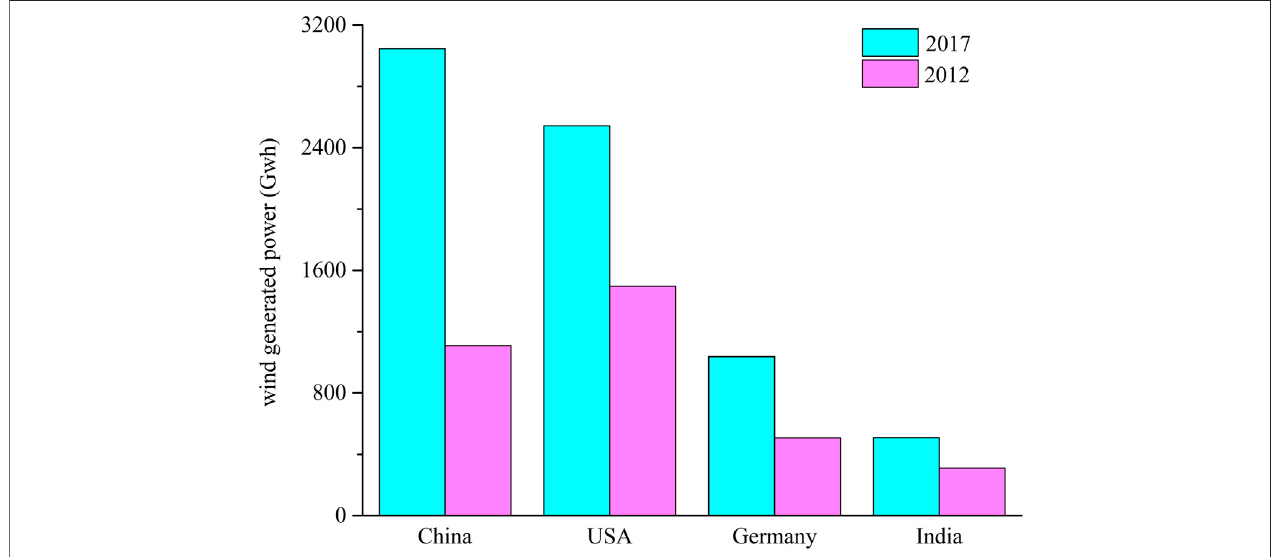
FIGURE 1 | Changes in wind energy output from 2012 to 2017 in the four countries with the highest wind power generation (China, the United States, Germany, and India).